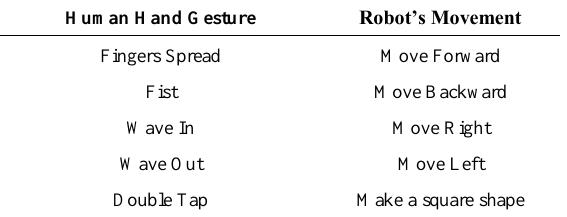
Table 1. The User’s Active Gestures vs. the Corresponding Robot’s Movements